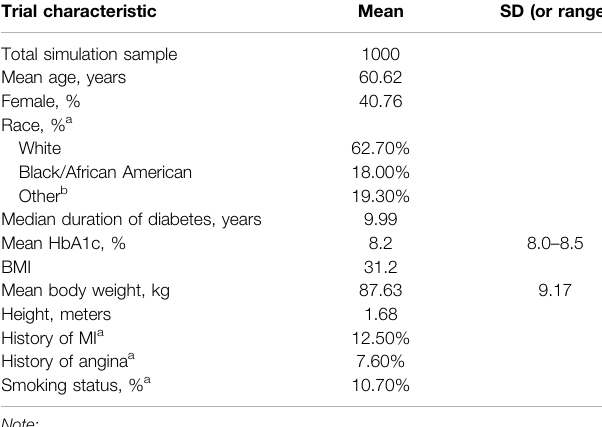
TABLE 2 | Baseline characteristics of the simulation